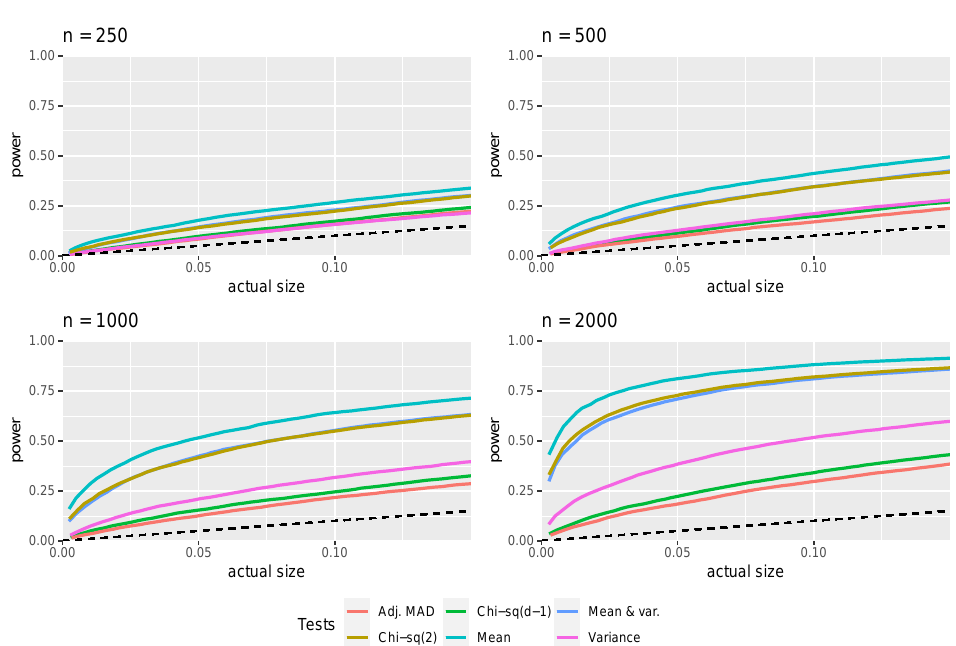
Figure 7. First two digits tests: size–power curves of the tests against the uniform mixing alternative with λ = 0.9. Tests are as follows: “Adj. MAD”, adjusted MAD (10); “Chi-sq(2)”, χ 2 ( 2 ) test on mean and variance (4); “Chi-sq(d-1)”, χ 2 ( 89 ) test (9); “Mean”, normal test on the mean (1); “Mean & var.”, normal test on mean and variance (3); “Variance”, normal test on variance (2). The dashed line is power = actual size . The number of observations is indicated on top of each panel.